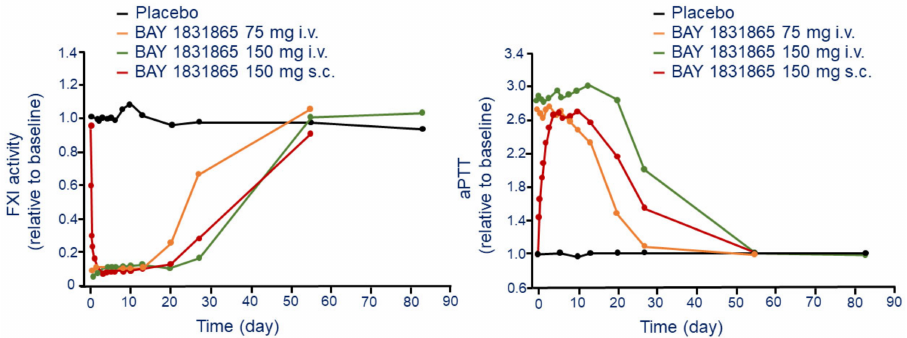
Figure 3. Time and dose-dependent effect of BAY 1831865 on FXI activity ( left panel ) and kaolin-induced aPTT ( right panel ) following a single i.v. and s.c. administration. Modified from Nowotny B. et al. [26]. F: factor; aPTT: activated partial thromboplastin